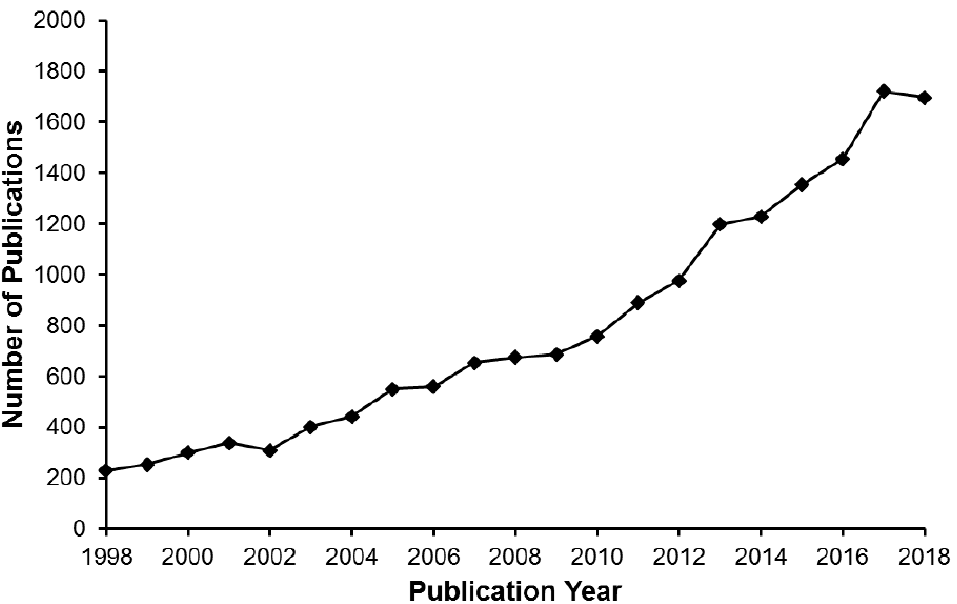
Figure 1. The number of publications for metal ion-imprinted polymers.